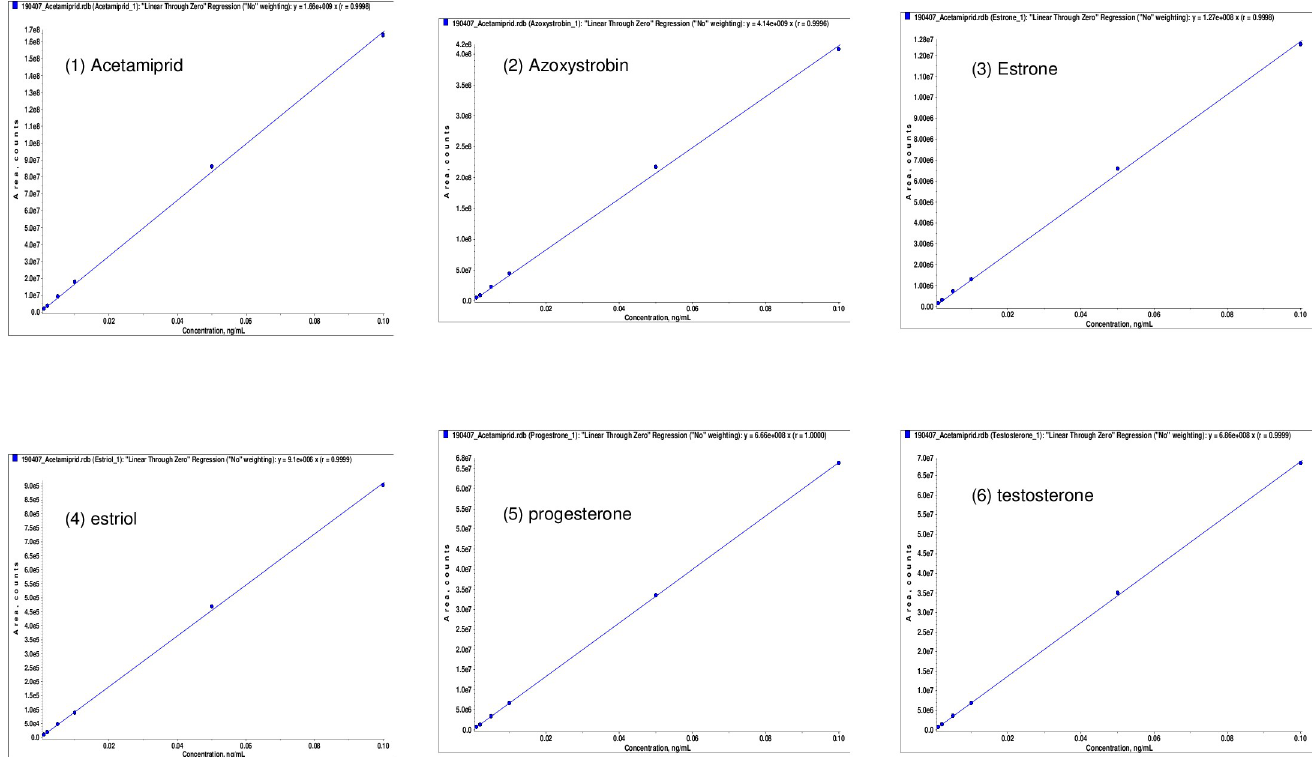
Fig 1. Linearity coefficients of calibration curves for all six compounds (acetamiprid, azoxystrobin, estrone, estriol, progesterone, and testosterone).